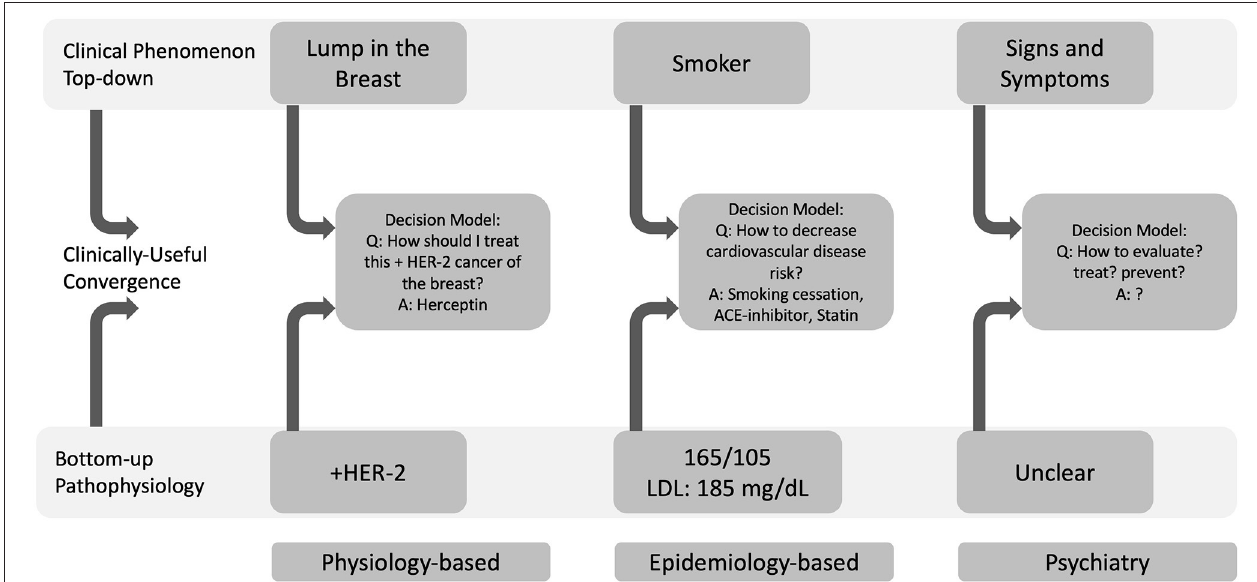
FIGURE 2 | Physiology-based (bottom-up) and epidemiology-based (top-down) approaches to biomarker development can define useful decision models. Decision models converge top-down clinical phenomena with bottom-up pathophysiology. In oncology, a physiology-based investigation indicated that HER-2 positivity in a cancer of the breast could be treated with Herceptin. In cardiology, the Framingham Heart Study’s epidemiology-based approach showed that smoking behavior (a top-down phenomenon), hypertension and high cholesterol were risk factors for cardiovascular disease. In psychiatry, it remains unclear how to define and operationalize decision models to approach clinical phenomena with pathophysiology and therefore, which data will be most helpful within these larger decision models (LDL, low-density